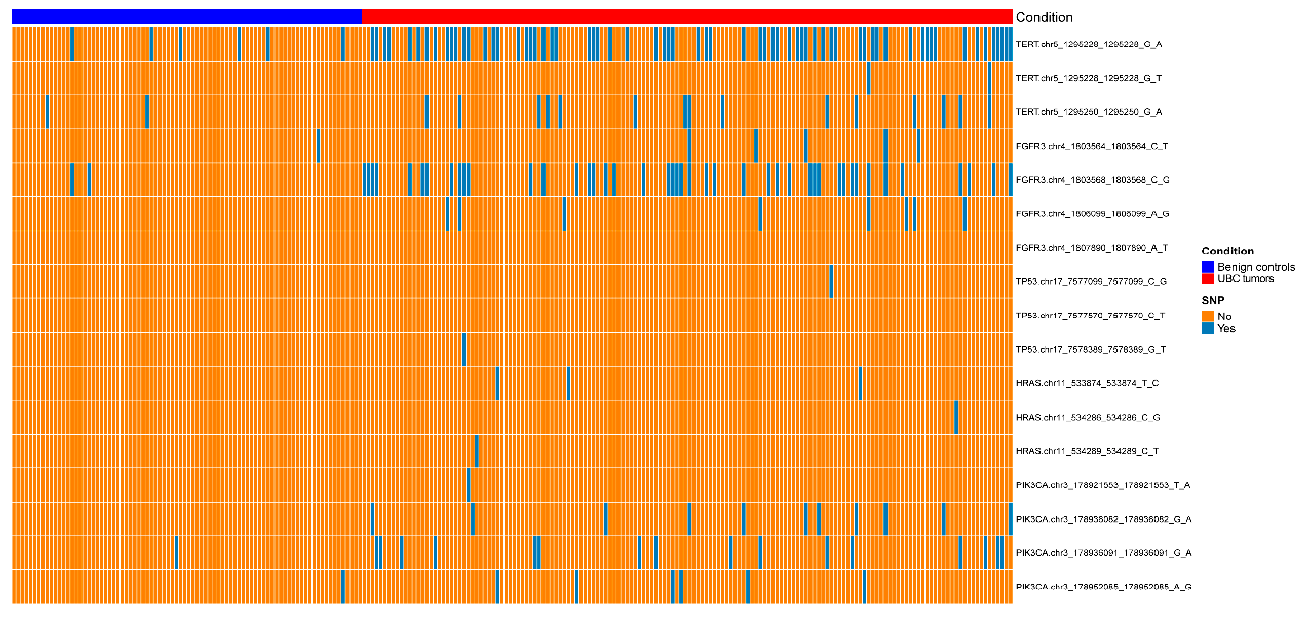
Figure 4. The heatmap of different SNP sites in cohort 3. The parameter “condition” represents the benign controls in blue and the UBC tumor samples in red.